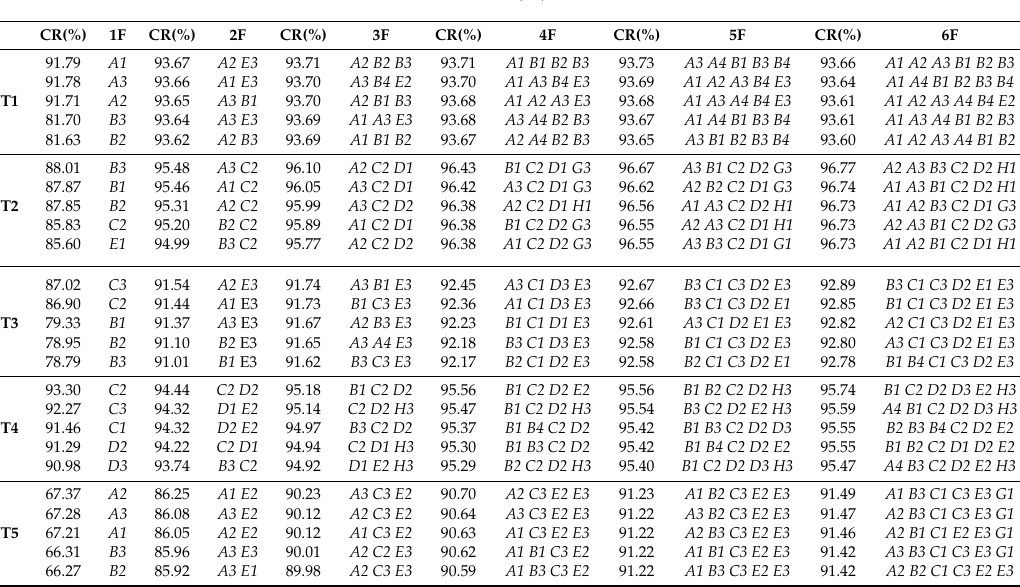
Table 3. CR (a) and F1-score (b) numerical results for the best features of the quasi-optimal feature selection algorithm. Results are grouped in sub-tables for each WT and each sub-table contains the top 5 results for this WT. The selected features are coded with the variable codes detailed in Table